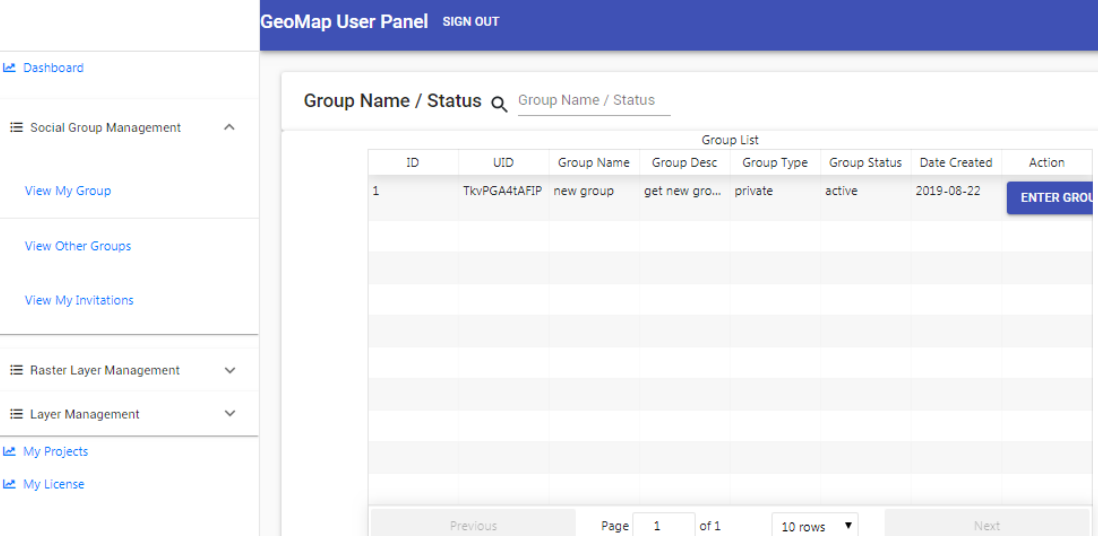
Figure 18: Example of joining a particular/private user group shared dataset from other group members (View My group-the account as Parent; View Other Group-the account as child/members – refers to Figure 16).